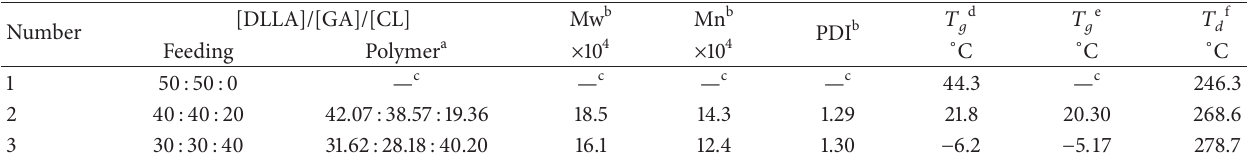
Scheme 1: Synthetic route of PLGC in the presence of Sn(Oct) 2 . Table 1: Ring-opening copolymerization of DLLA, GA, and CL in the bulk with Sn(Oct) 2 .